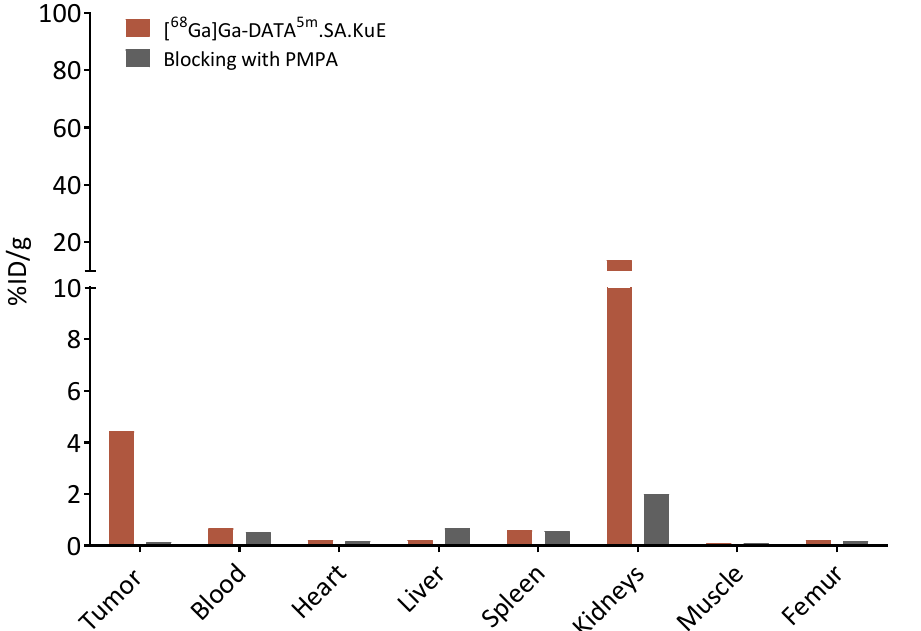
Figure 9. Ex vivo biodistribution data of [ 44 Sc]Sc-AAZTA 5 .SA.KuE, [ 177 Lu]Lu-AAZTA 5 .SA.KuE, [ 68 Ga]Ga-DATA 5m .SA.KuE and [ 68 Ga]Ga-PSMA-11 in LNCaP tumor-bearing Balb/c nude mice 1 h p.i. %ID/g: % injected dose per gram. Values are mean ± SD.